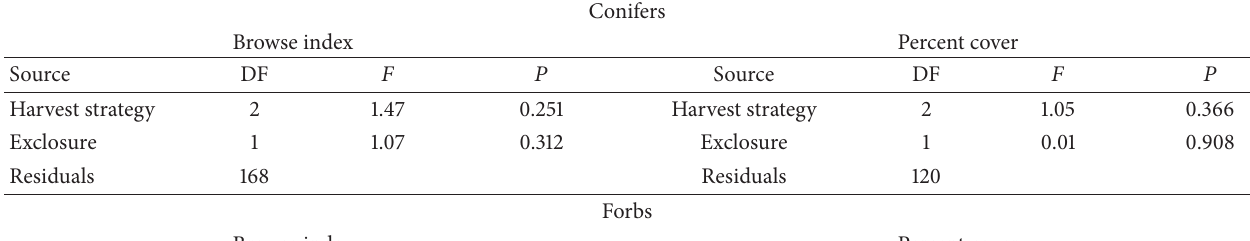
Table 1: Three-factor repeated measures ANOVA used to examine the mean browse index and percent cover for conifer, forb, shrub, and hardwood plant groups at YMF. Independent factors were harvest strategy and exclosure presence, and the repeated factor was month. Only the main effects are